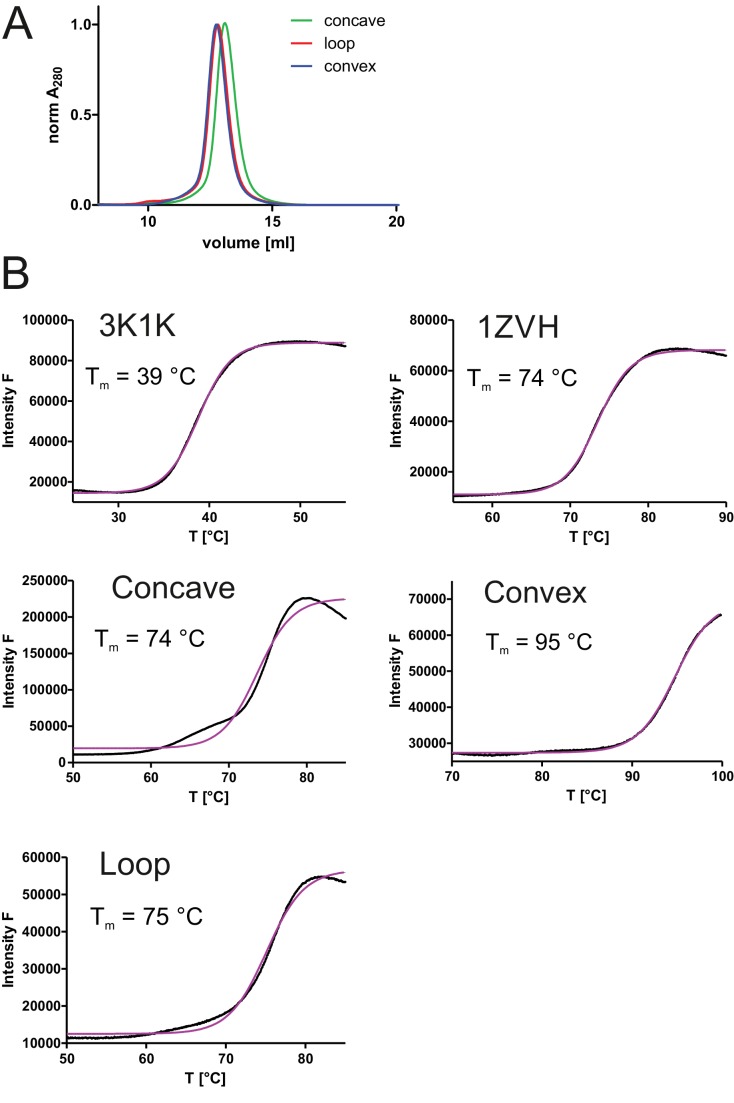
Biophysical characterization of sybodies.Three framework sybodies representing the concave, the loop and the convex library and containing serines and threonines in the randomized positions were generated by gene synthesis (sequences provided in Figure 1—figure supplement 2). (A) SEC analysis of periplasmatically expressed concave, loop and convex framework sybodies using a Superdex 75 300/10 GL column. (B) Determination of melting temperature (Tm) of framework sybodies and their natural precursors 3K1K and 1ZVH using dye SYPRO Orange (ThermoFluor). Representative data of two technical replicates are shown.